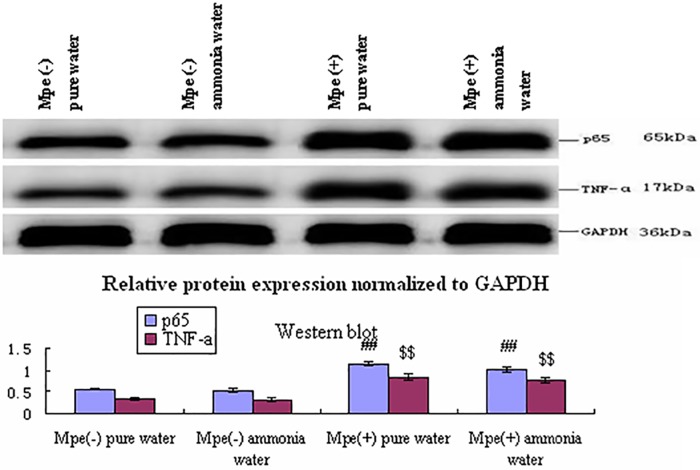
The p65 and TNF-α expression in different groups.Western blot analysis of p65 and TNF-α protein expression in gastric mucosa of Mpe infected and uninfected mice sub-groups. Data is representative of three independent experiments (n = 3). (# <0.01, $ <0.01).